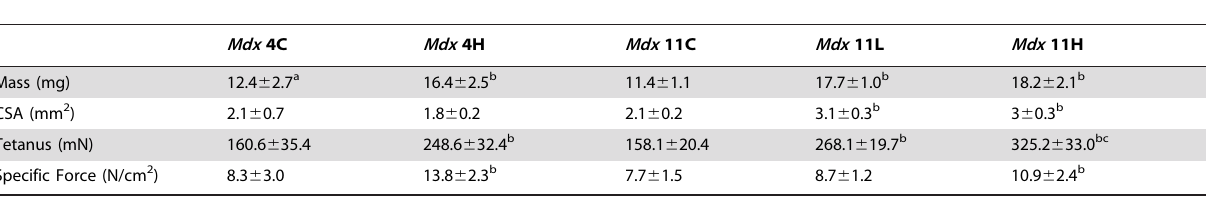
Table 3. Functional properties of soleus muscle in mdx